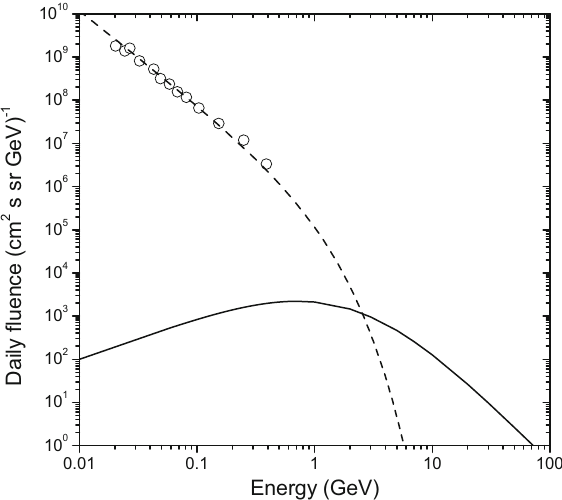
Fig. 23 Daily fluence of solar energetic particles ( dashed curve —Tylka and Dietrich 2009) and galactic cosmicrays( solidcurve )forthedayofJanuary20,2005. Opencircles representspace-bornemeasurements (Mewaldt 2006; Mewaldt et al.